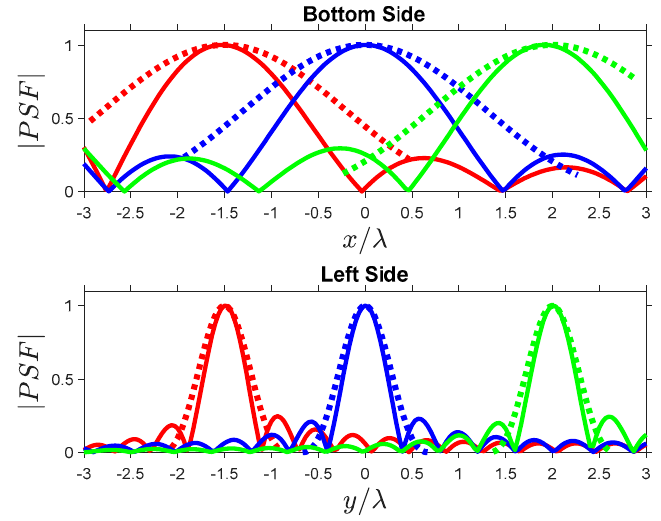
Figure 12. Comparison of the actual PSF (dotted lines) and approximated (cid:103) PSF (solid lines) for the bottom and left sides in the transmission mode for x 0 = − 1.5 λ (red lines), x 0 = 0 λ (blue lines), and x 0 = 2 λ (green lines).